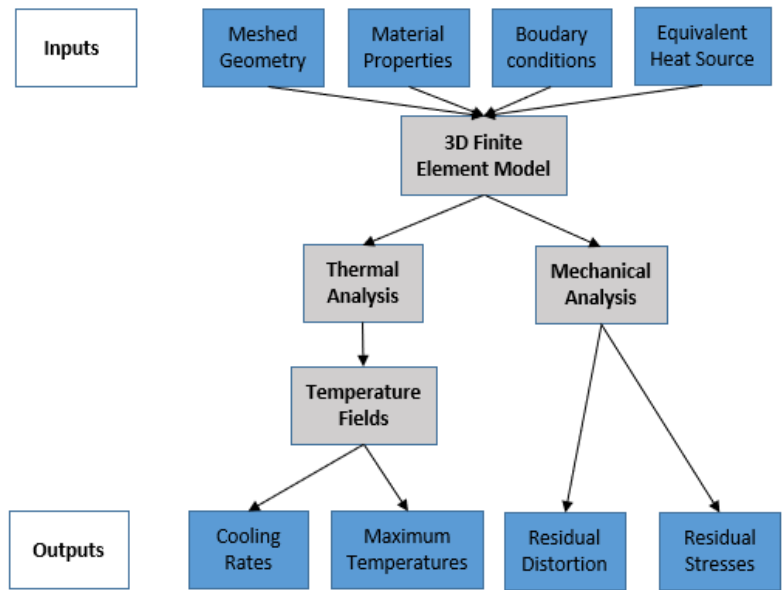
Figure 2. Diagram of the welding simulation procedure. Reproduced from [5], with permission from Elsevier, 2019.